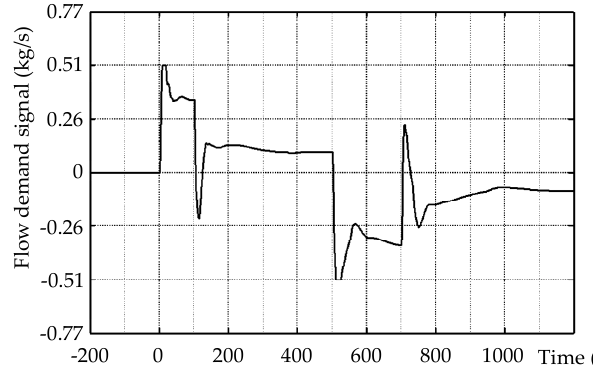
Figure 12. DMC supplementary fuel flow demand of 600-MW plant.